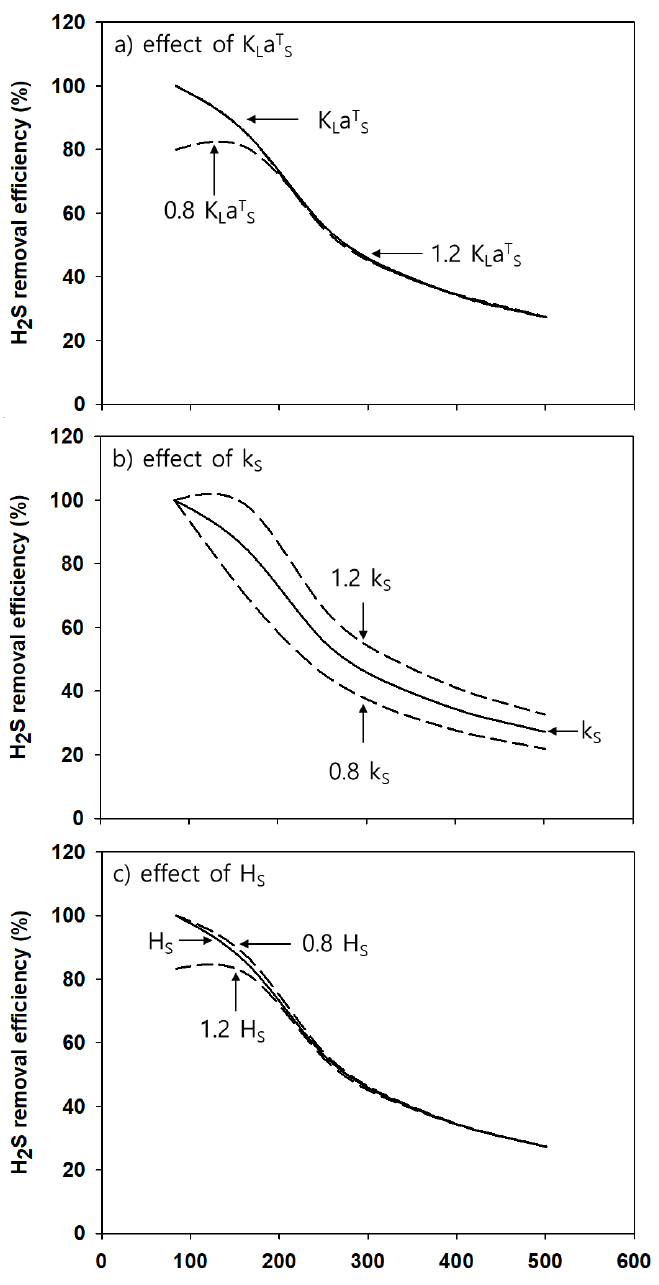
Figure 3. Sensitivity of the main parameters for H 2 S (H 2 S loading rate (g m − 3 h − 1 ) versus H 2 S re- moval rate (%)): effects of ( a ) mass transfer coefficient, ( b ) first-order kinetic constant, and ( c ) Henry’s law constant (full line represents prediction based on original value, dotted line represents 20% variation of parameters).